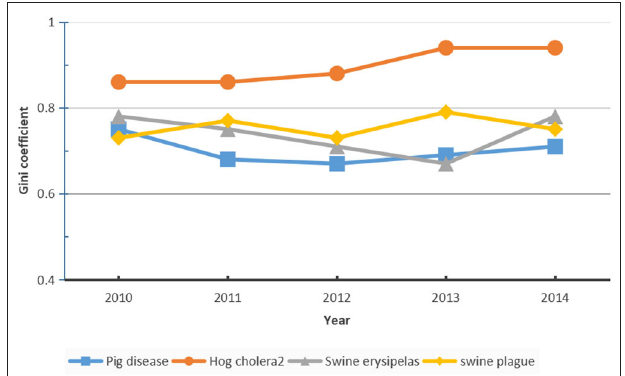
FIGURE 2 | Epidemic index of animal diseases.